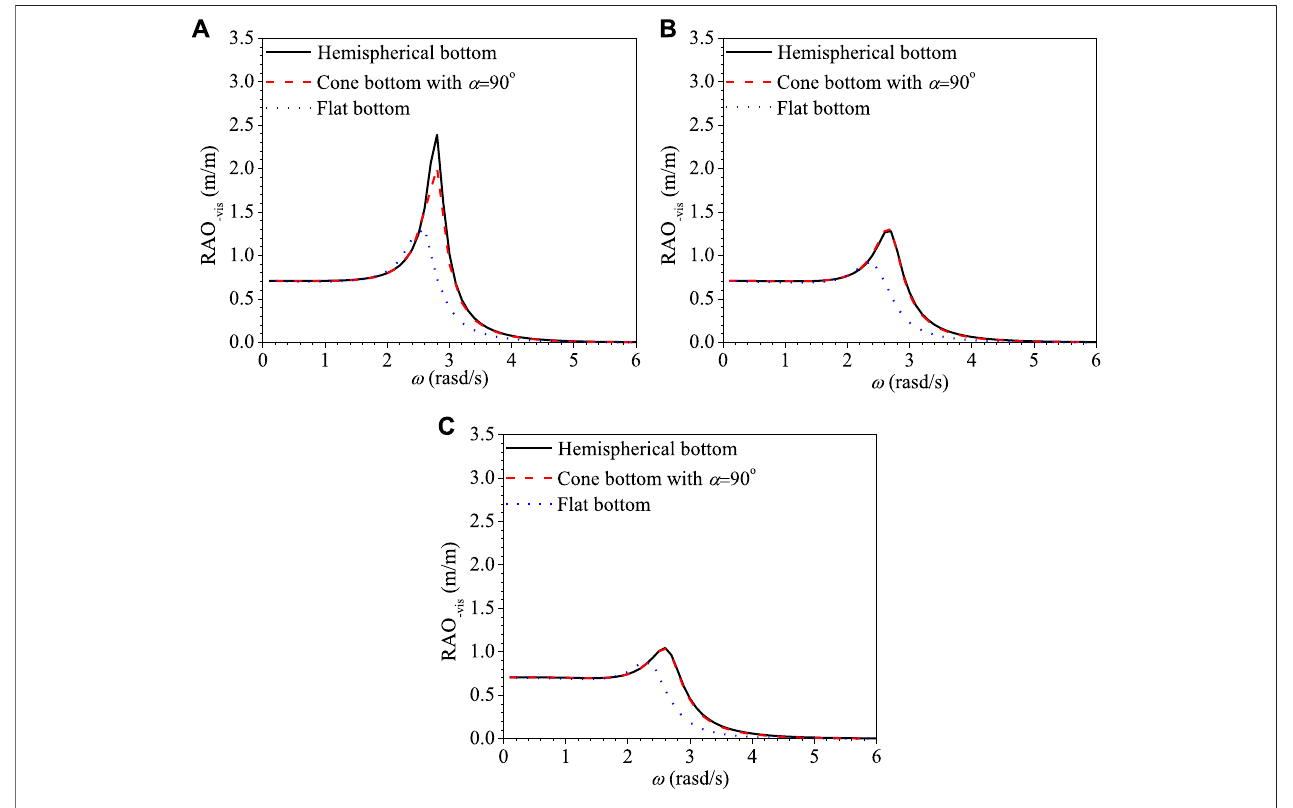
Figure 8 | Variations of RAO versus ω with different bottom shapes based on PFT with viscous correction. (A) 2 r / d (cid:2) 1.6. (B) 2 r / d (cid:2) 2.4. (C) 2 r / d (cid:2) 2.8.